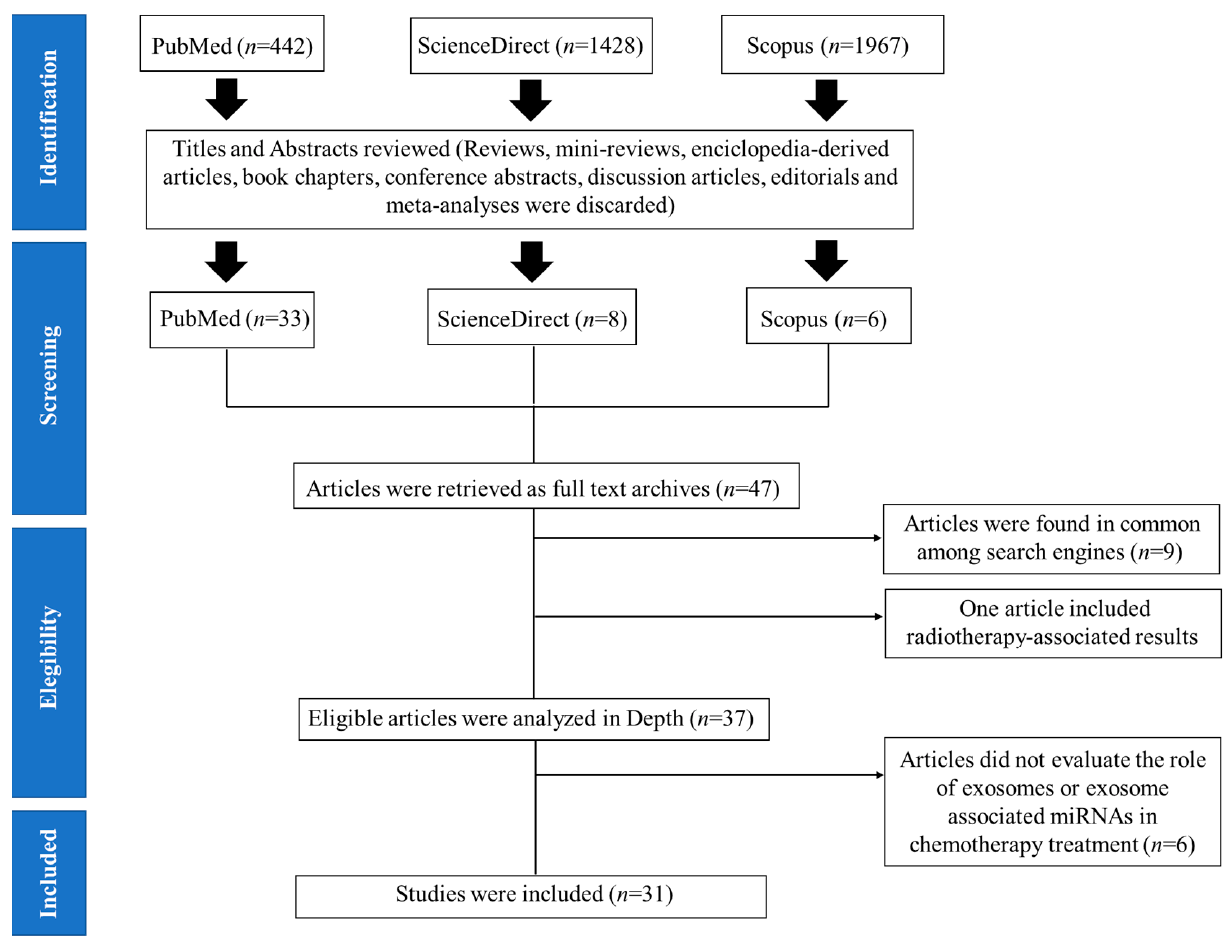
Figure 2. Overview of the literature study and selection process.